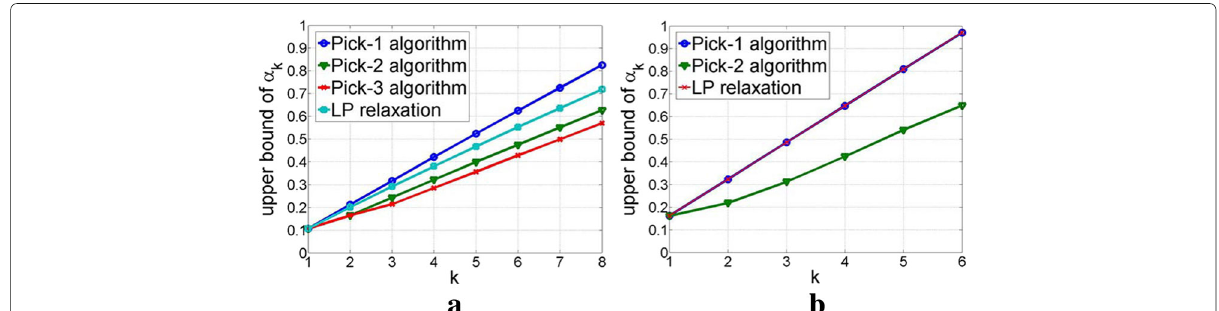
Fig. 2 Median upper bounds of α k from the pick- l algorithm and the LP relaxation method. a 128 × 256 Gaussian matrices b 64 × 256 partial Fourier